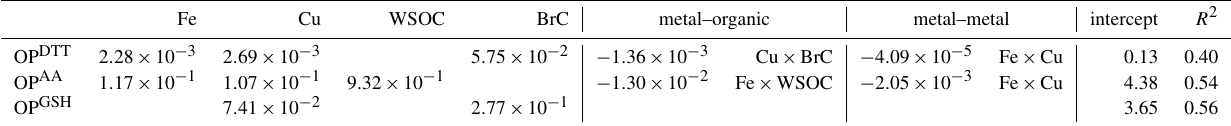
Table 2. Multivariate linear regression models for OP metrics.